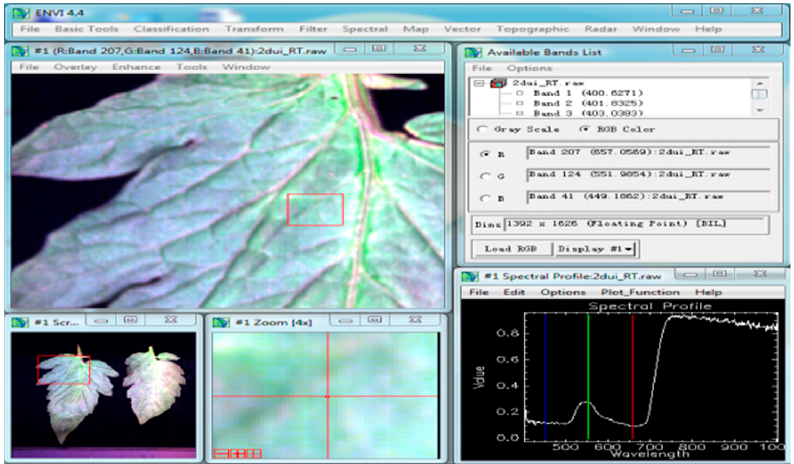
Figure 3. The interface of ENVI software for extracting spectra.